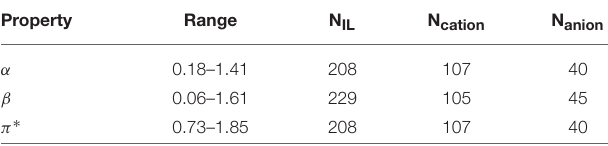
TABLE 1 | Summary of the experimental